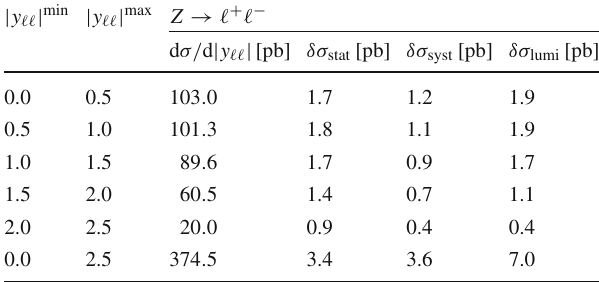
Table 8 Combined fiducial Z → (cid:5) + (cid:5) − differential and integrated cross sections